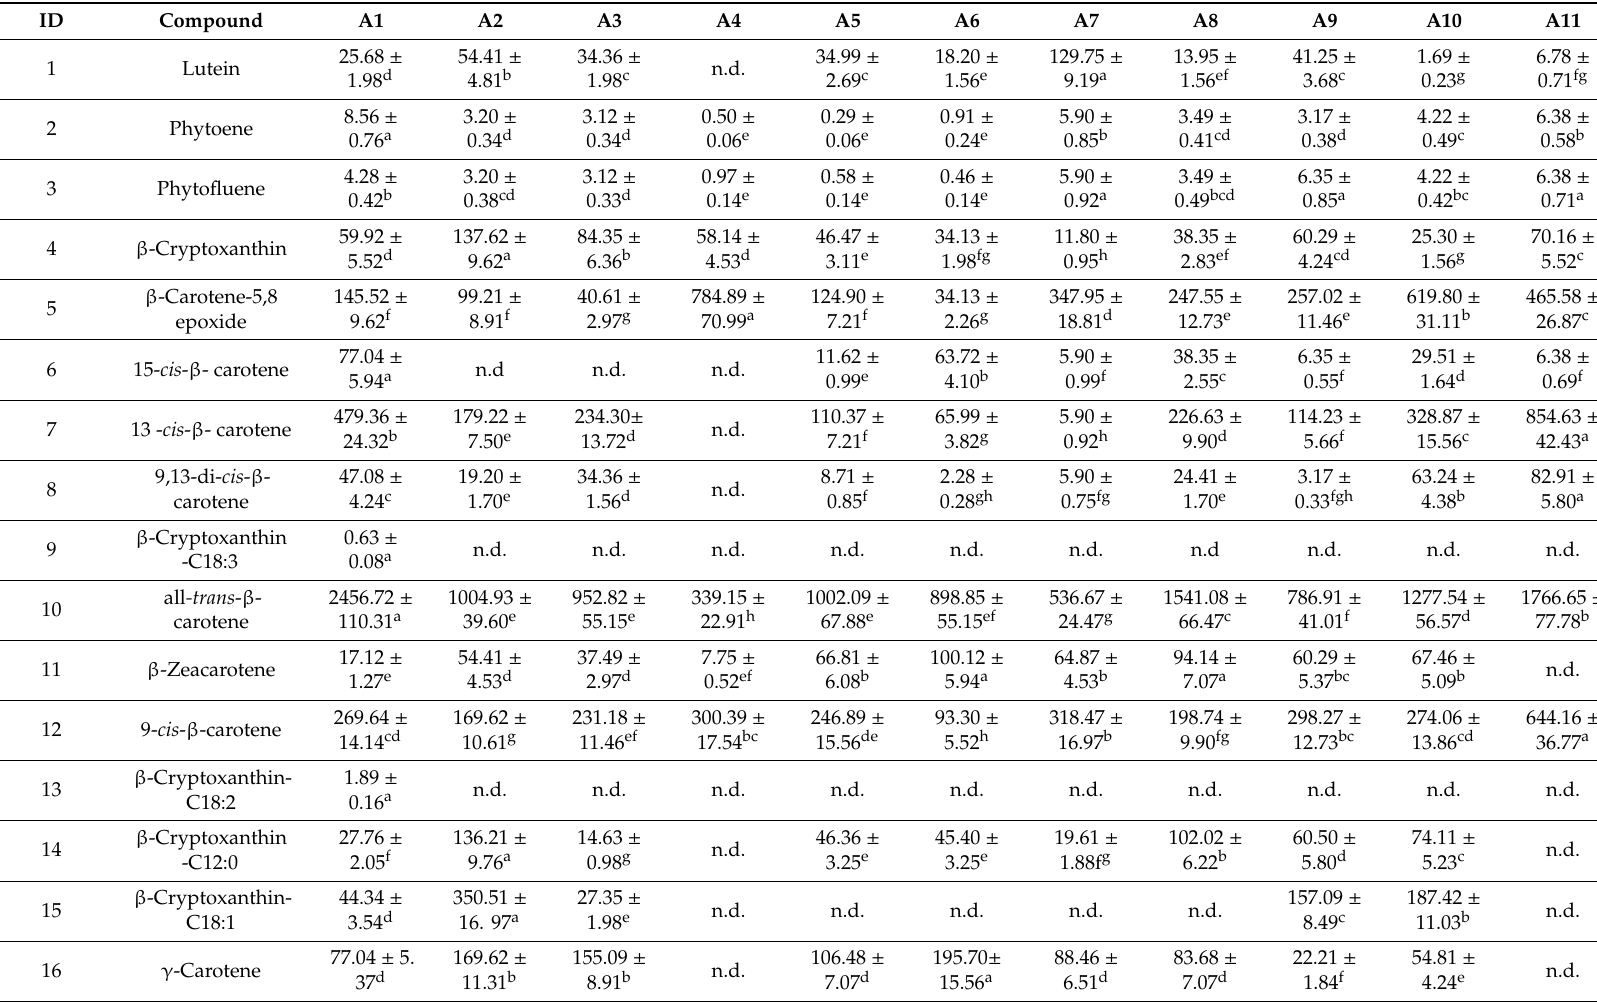
Table 2. Carotenoids composition ( µ g / 100 g fresh weight (FW) +/ − SD a ) in 11 cultivars of apricots. a Mean of three replicates, +/ − SD (standard deviation). Di ff erent superscript letters ( a–h ) in the same row mean significant di ff erences. n.d. = not